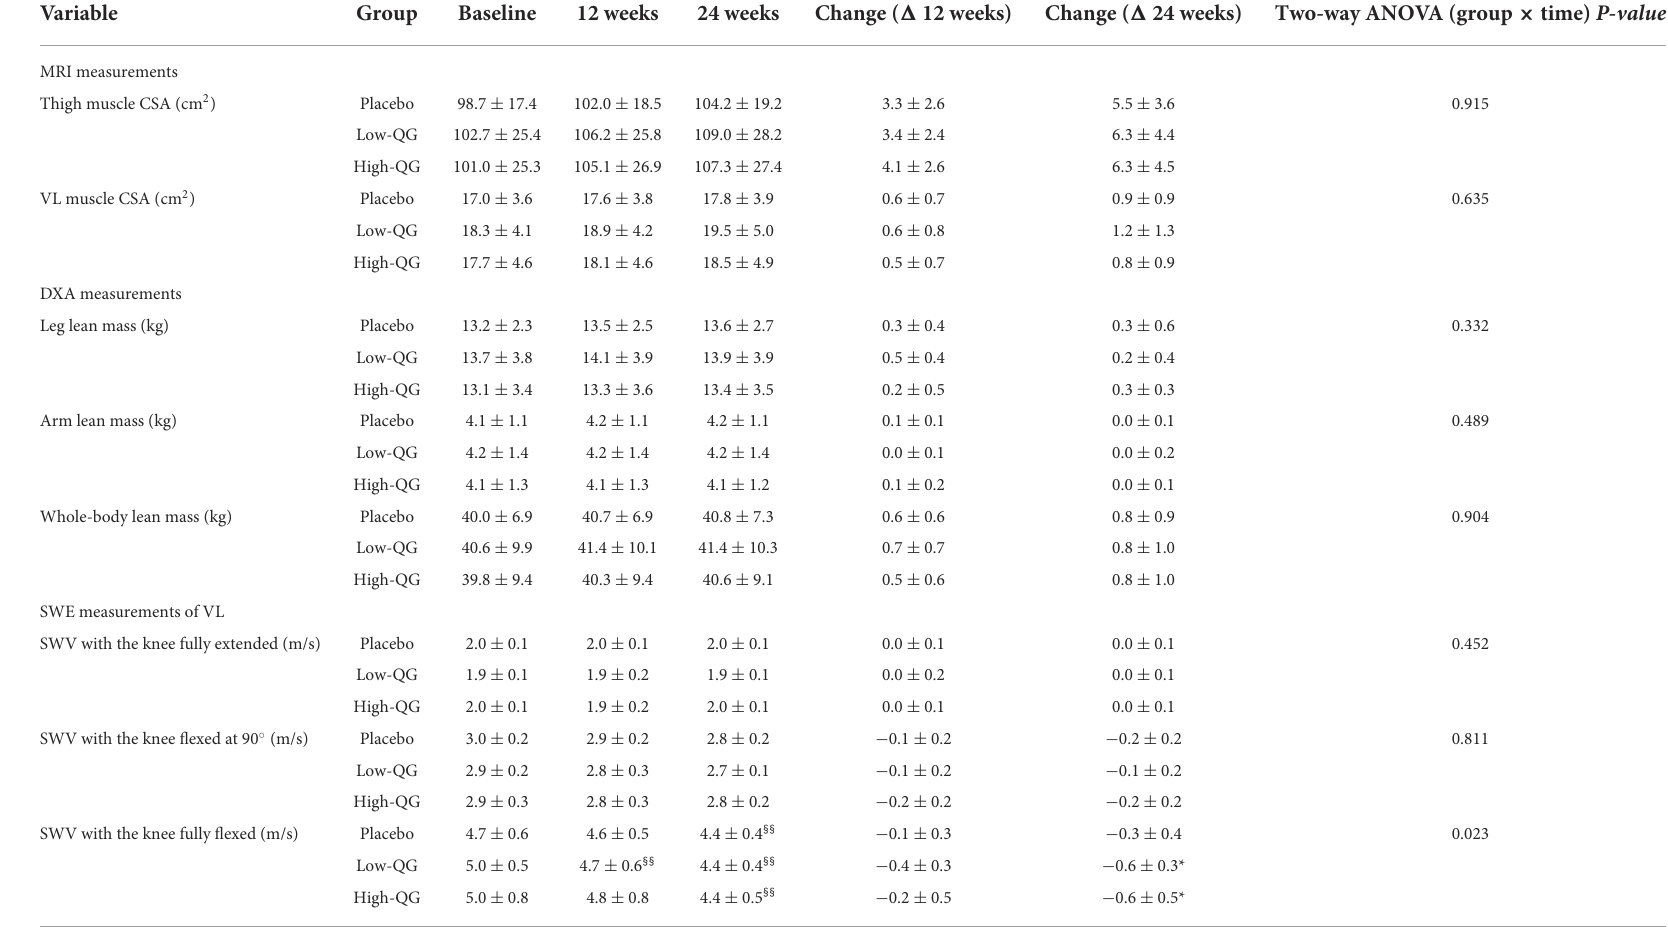
TABLE 2 Effects of the intervention on muscle quantity and stiffness in the PPS analysis. Variable Group